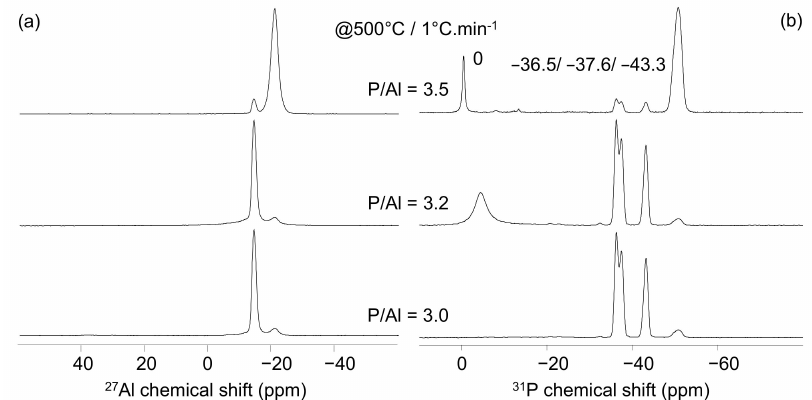
Figure 3. 27 Al ( a ) and 31 P ( b ) MAS-NMR spectra obtained at 500 ◦ C on Al/P = 3 (bottom), 3.2 (middle), and 3.5 (top) solutions.